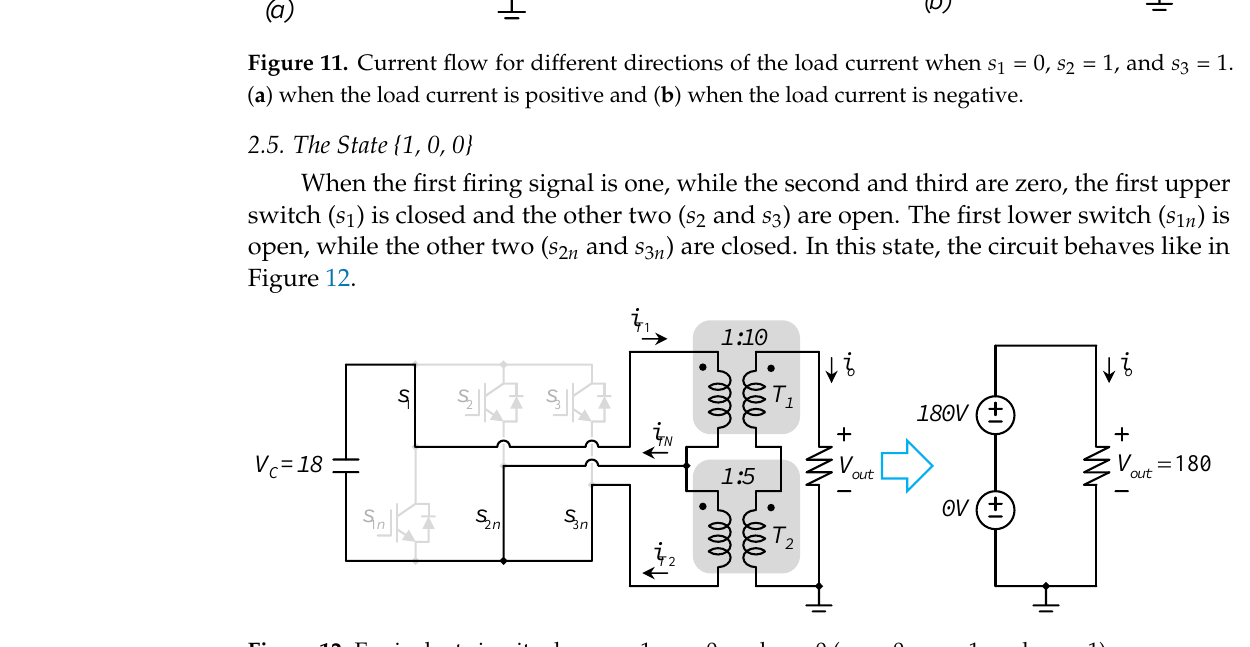
Figure 12. Equivalent circuit when s 1 = 1, s 2 = 0, and s 3 = 0 ( s 1 n = 0, s 2 n = 1, and s 3 n = 1). The primary winding of the transformer T 1 is connected to the input source, in a positive manner (the dot is connected to the positive side of the input power source), then it provides 180 V to the output. The primary winding of the transformer T 2 is shorted